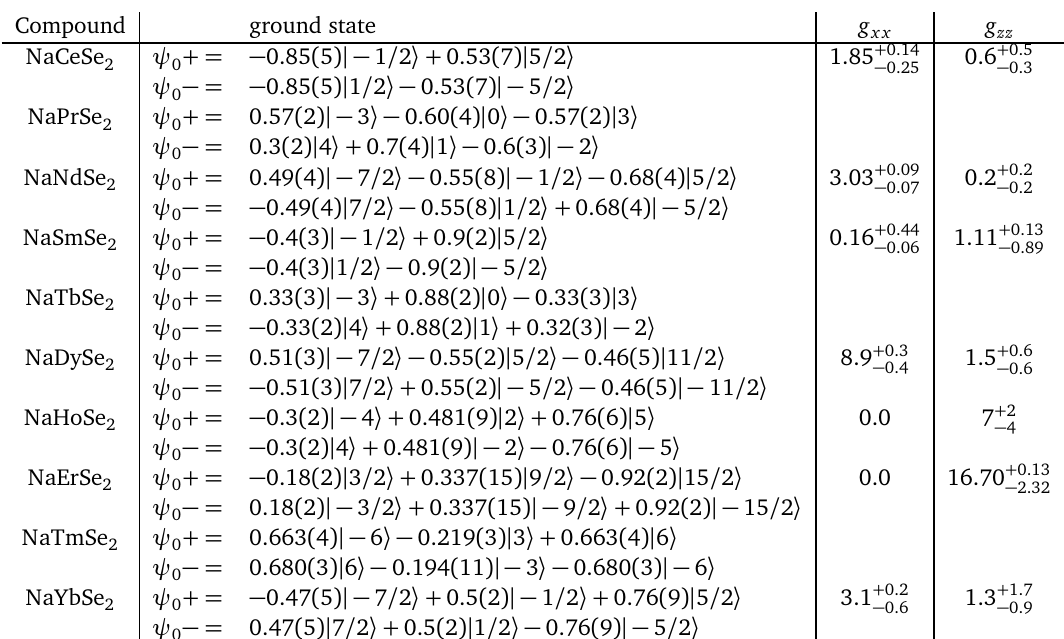
Table 4: Uncertainties in the fitted CEF Hamiltonian of delafossite materials based off the NaErSe structure. Only ions with doublet ground states have listed g tensors, 2 some ions (Tm and Pr) have near doublet ground states with the lowest two eigenkets